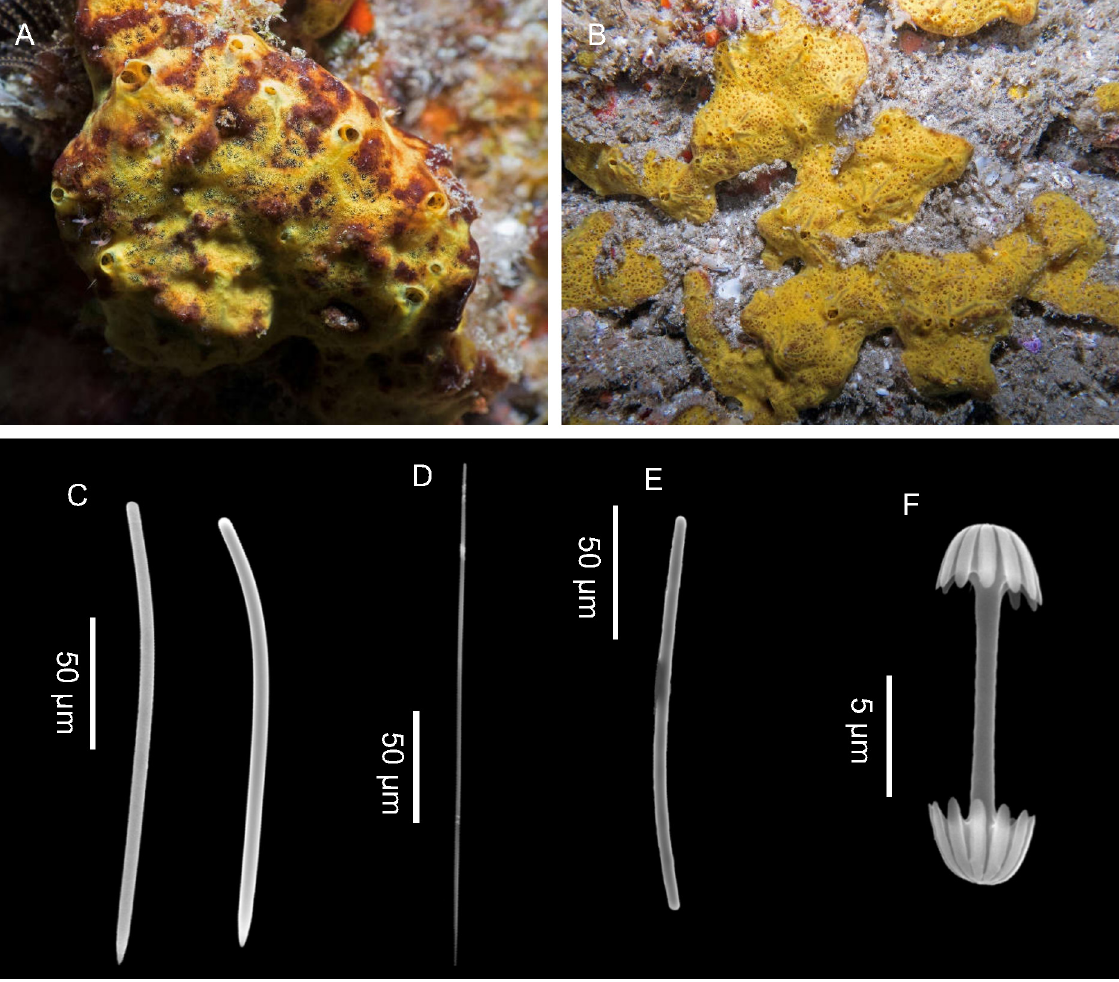
Fig. 20. Iotrochota cf. sinki Samaai et al . 2019. A–B . Massive (PO85) and encrusting (PO100) specimens in situ . C . Styles. D . Thin and straight style. E . Slightly curved strongyle. F .